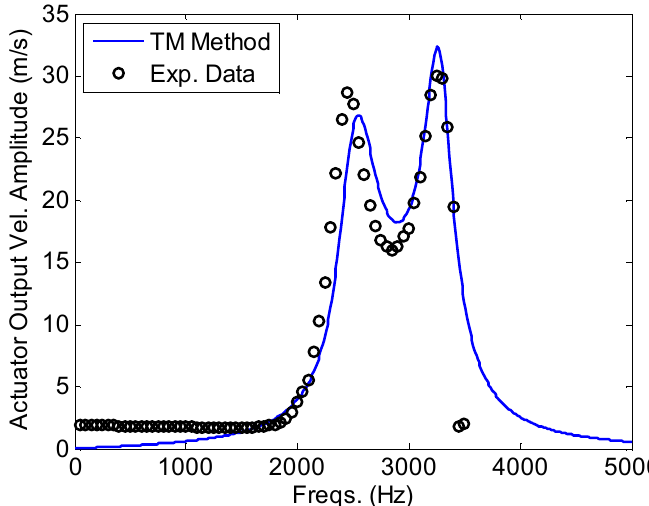
Fig. 16 Comparison between TM, LEM and experimental data of jet velocity for a synthetic-jet actuator with dual cavities (Case